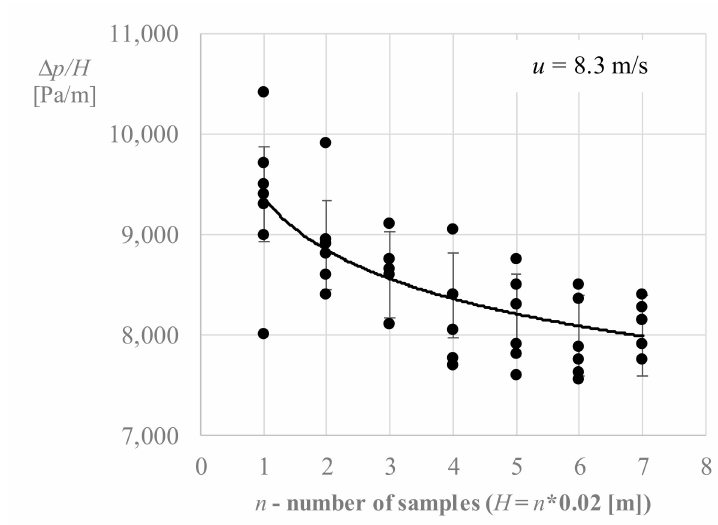
Figure 2. Pressure gradient across the total thickness of the assembly made with AL-10-96 samples as a function of the number of samples coupled and the air frontal velocity: ( a ) u = 3.1 m / s; ( b ) 8.3 m /